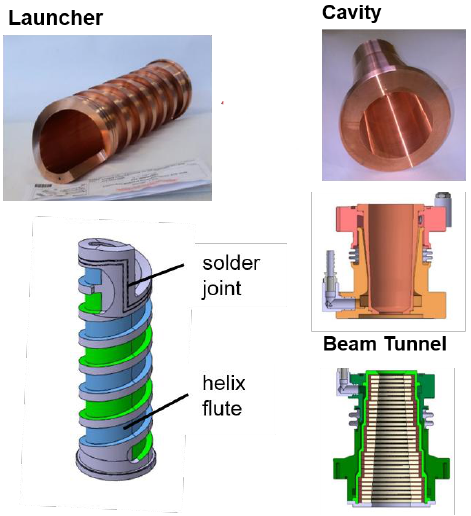
Fig. 4. Water-cooled subcomponents of the KIT 170 GHz 2 MW coaxial cavity gyrotron for pulse lengths up to 1 s.